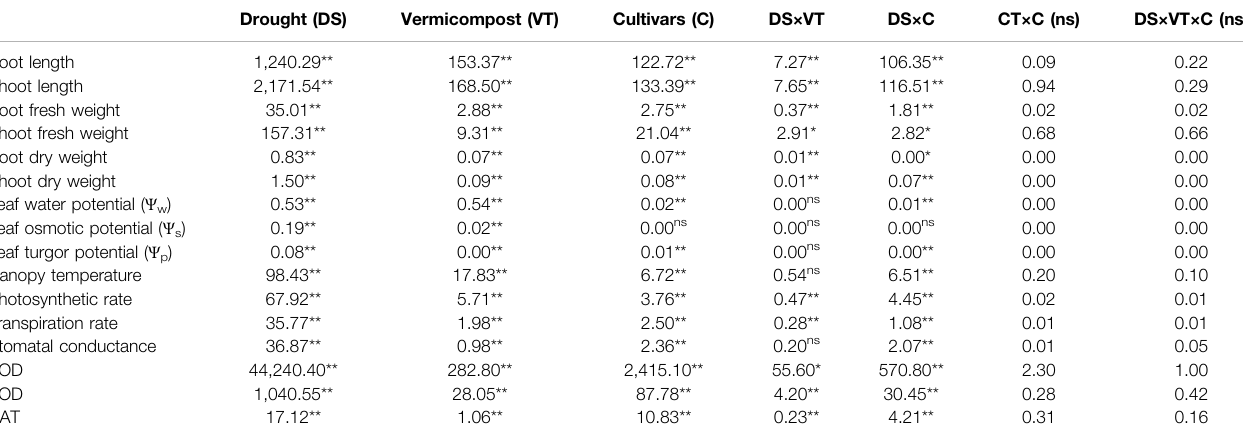
TABLE 2 | Mean sum of squares regarding the effect of soil-applied wheat straw vermicompost on the growth and physio-biochemical attributes of wheat cultivars under drought stress. Drought (DS)